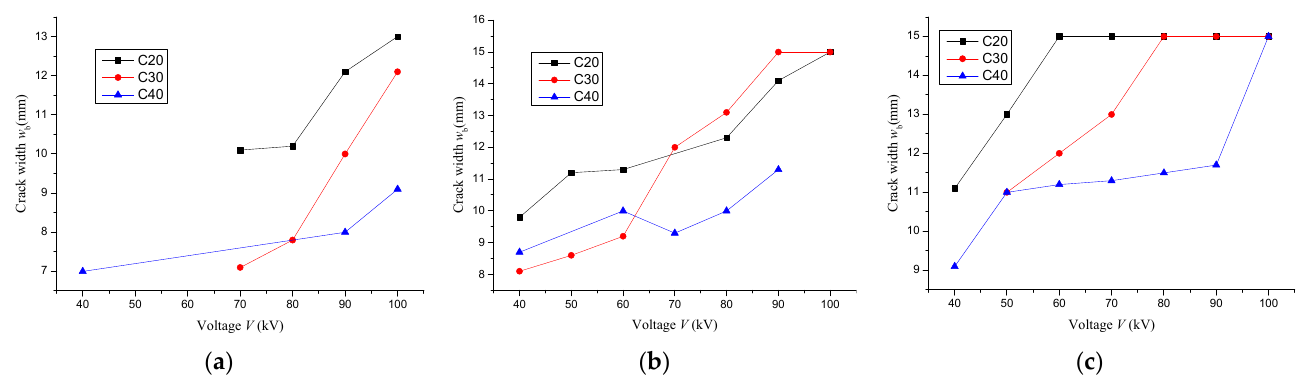
Figure 11. Relationship between crack width w b and discharge voltage V . ( a ) 40 copper wires; ( b ) 50 copper wires; ( c ) 60 copper wires.